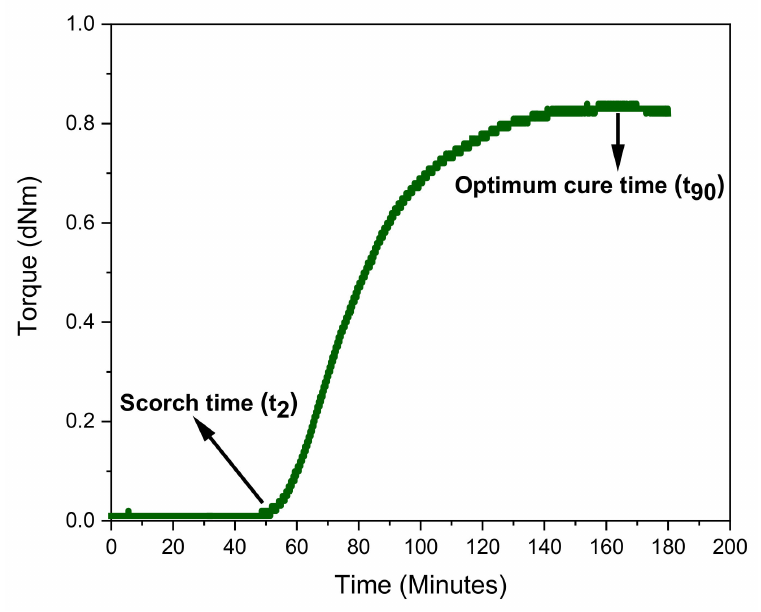
Figure 4. Vulcanization isotherm of the LBR-matrix at 75 ◦ with indications of scorch time and optimal cure